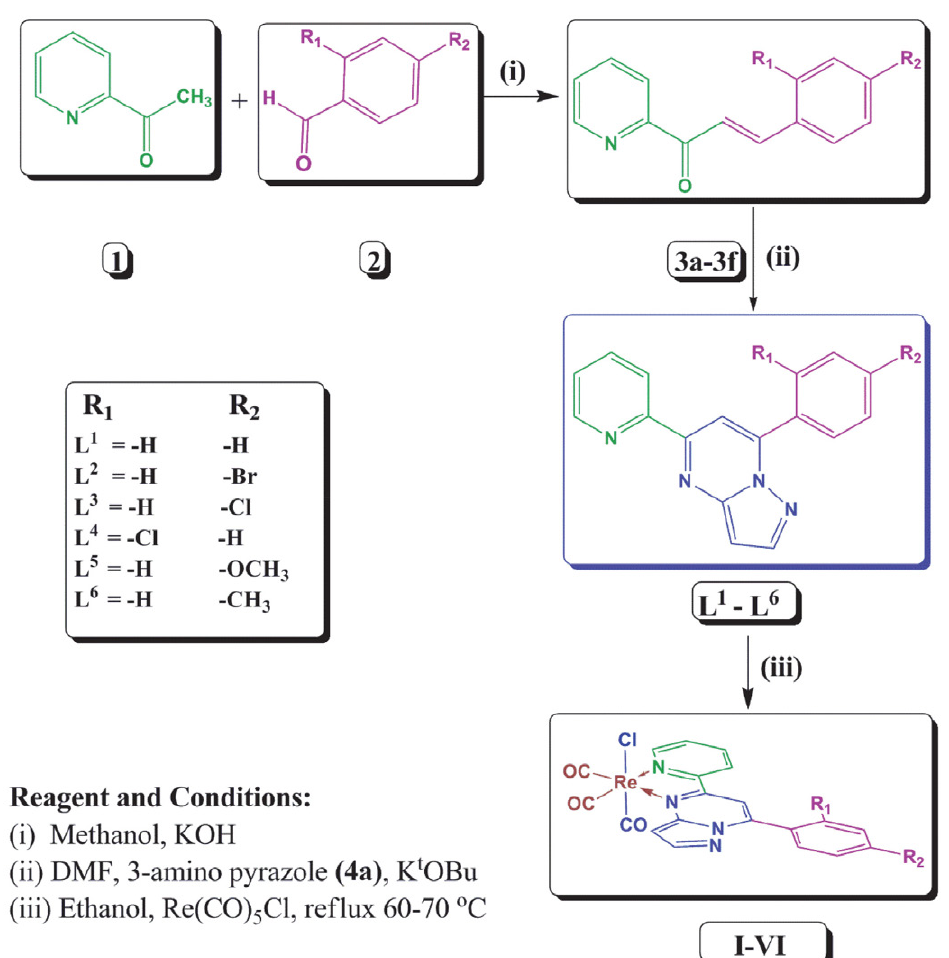
Scheme 1. Reaction scheme for the synthesis of ligands and rhenium